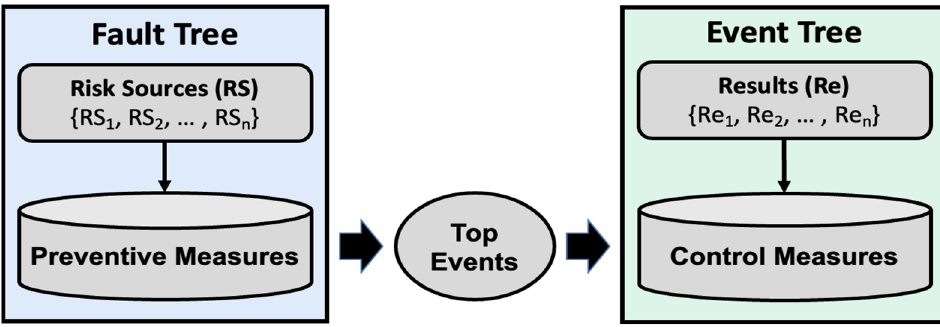
Figure 4. A state transition diagram during FPE based on Markov chain.